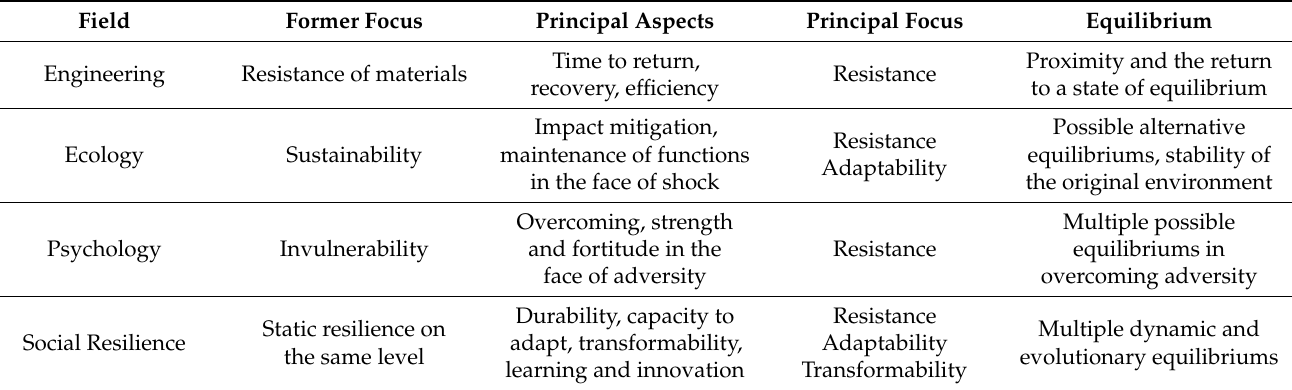
Figure 2. Relationship diagram and characteristics process. Each of these three characteristics also have a specific temporal frame of reference. The first, resistance, the capacity to withstand change, is strongly rooted in the past; adaptability refers to the present while transformability is oriented towards the future of the system and society. These aspects are summarized in Table 2. Table 2. Summary of aspects of resilience and its principal characteristics.